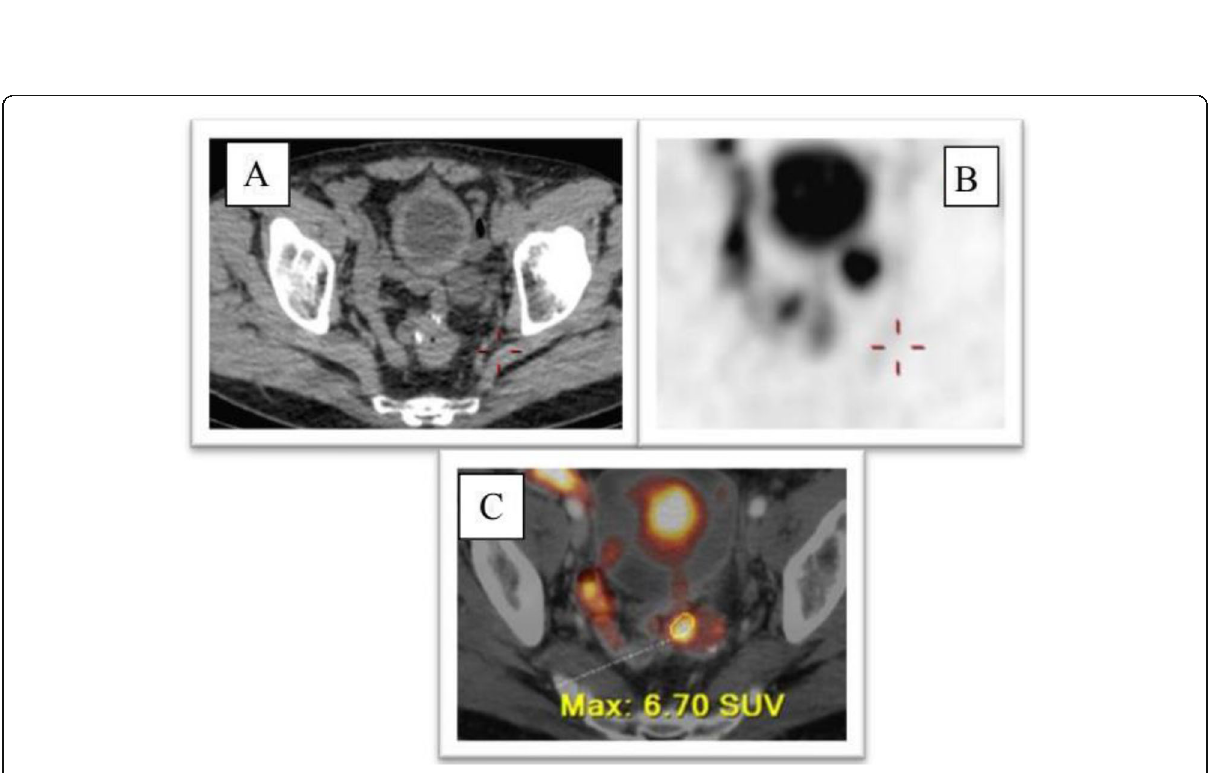
Fig. 6 A 70-year-old male patient with a history of surgically resected sigmoid cancer followed by chemotherapy, presented by elevated CEA and referred for PET/CT assessment. a Axial CT, b axial PET, and c axial PET/CT showing the following: ill-defined metabolically active soft tissue lesion at the left side of the pelvis related to the recto-sigmoid anastomotic site measuring 29 × 19 mm ( a , b ) and achieving 6.70 SUV max ( c